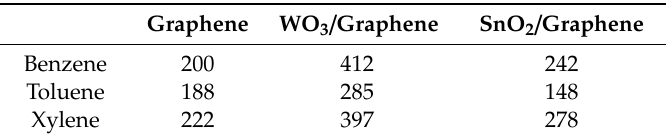
Table 4. Recovery time